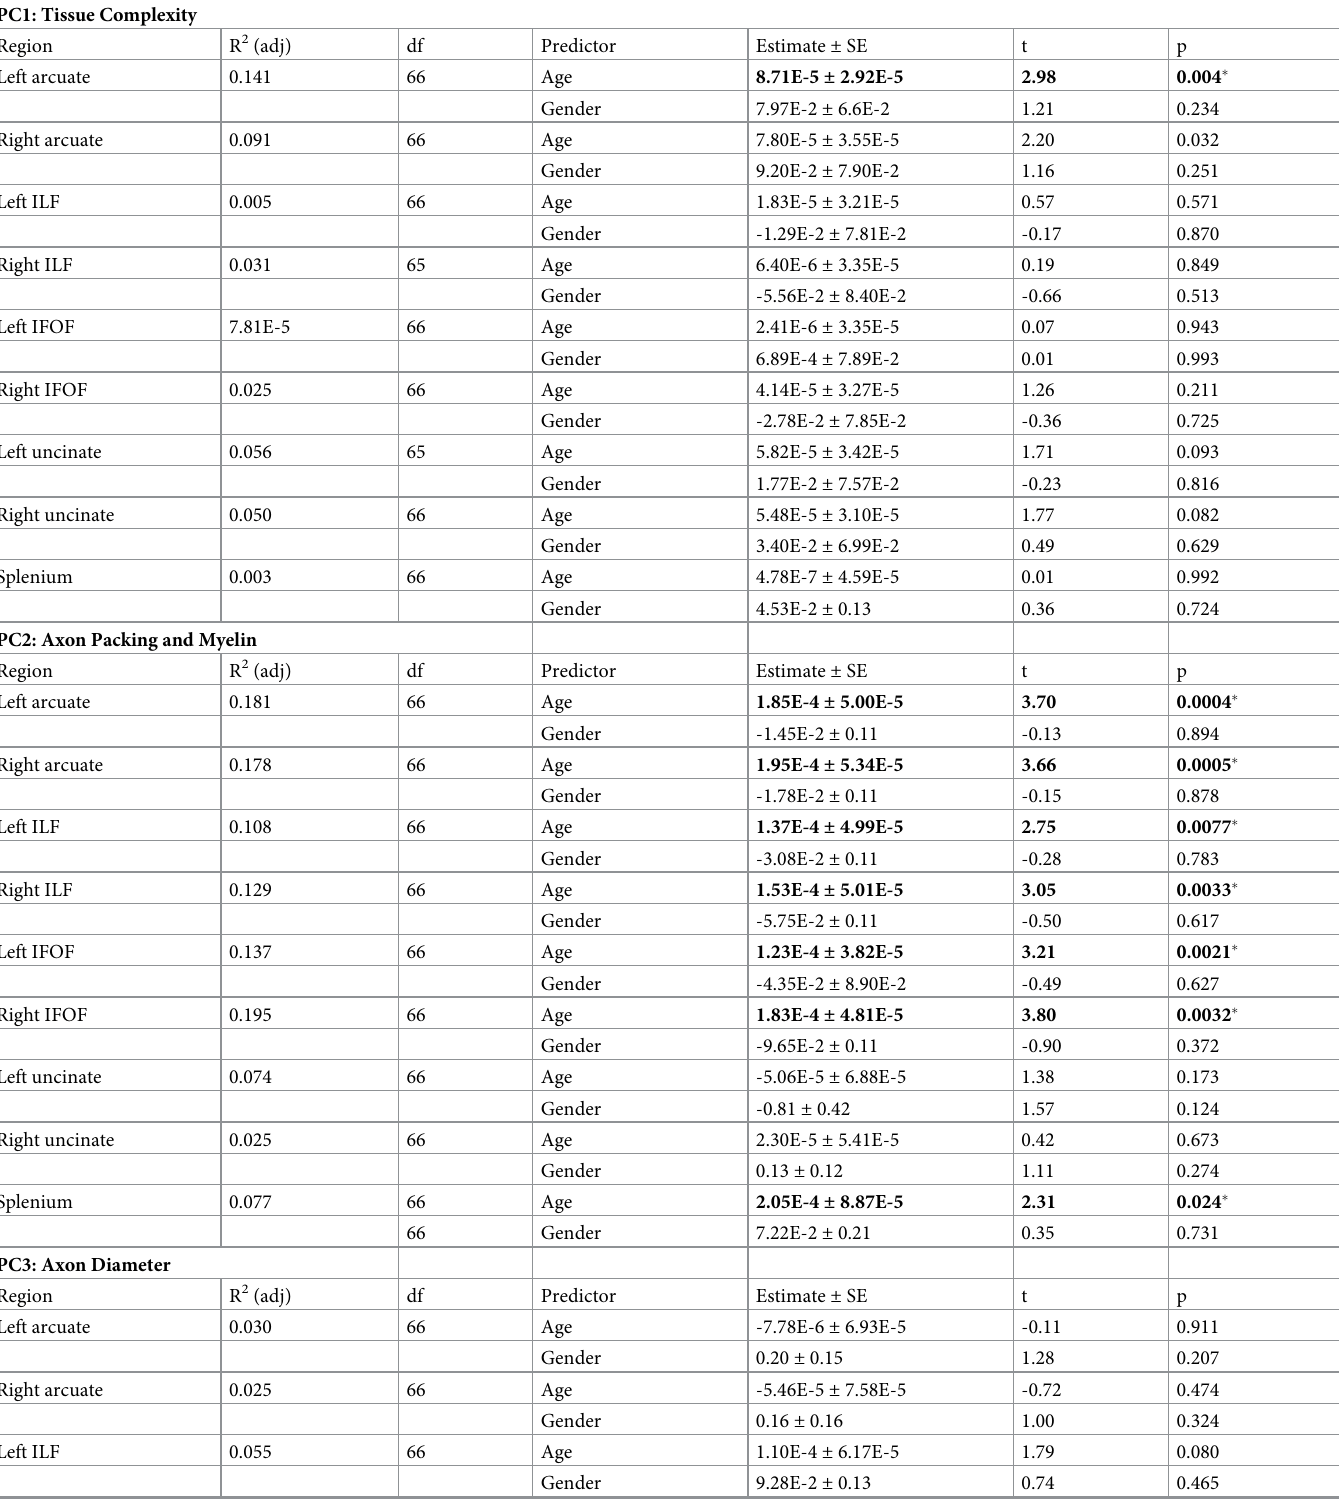
Table 2. Parameters for mixed effects regression models linking principal components to age and gender (formula: PC ~ Age + Gender + Age � Gender + (1| Subject )). PC1: Tissue Complexity